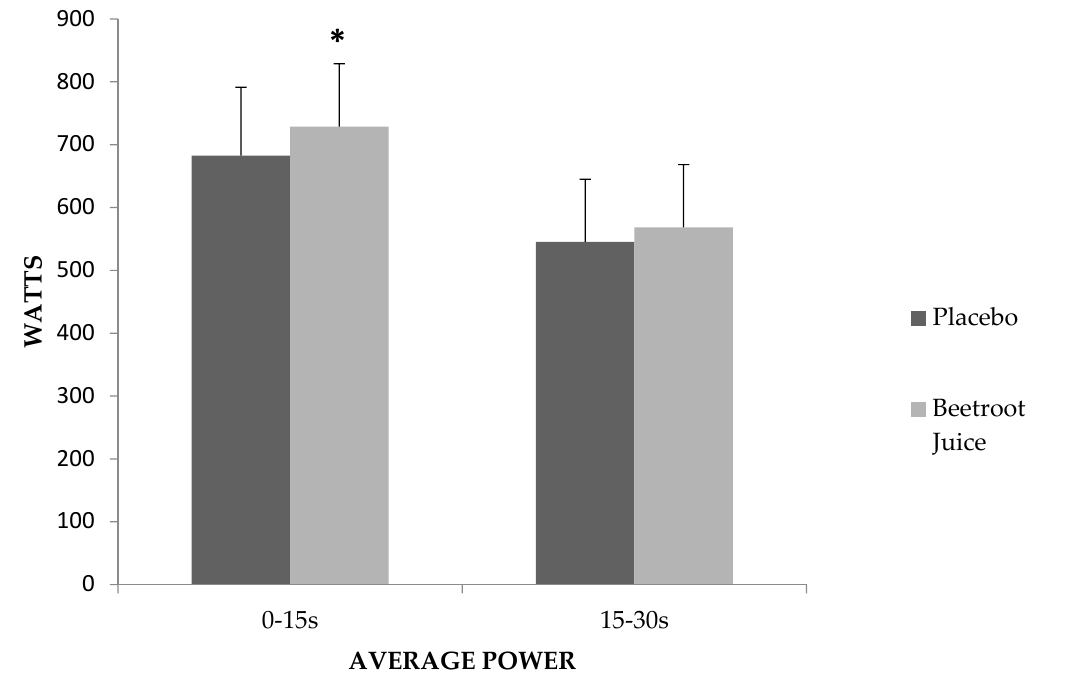
Figure 2. Average power recorded in the intervals 0–15 and 15–30 s; * significant difference between beetroot juice and placebo ( p < 0.05).